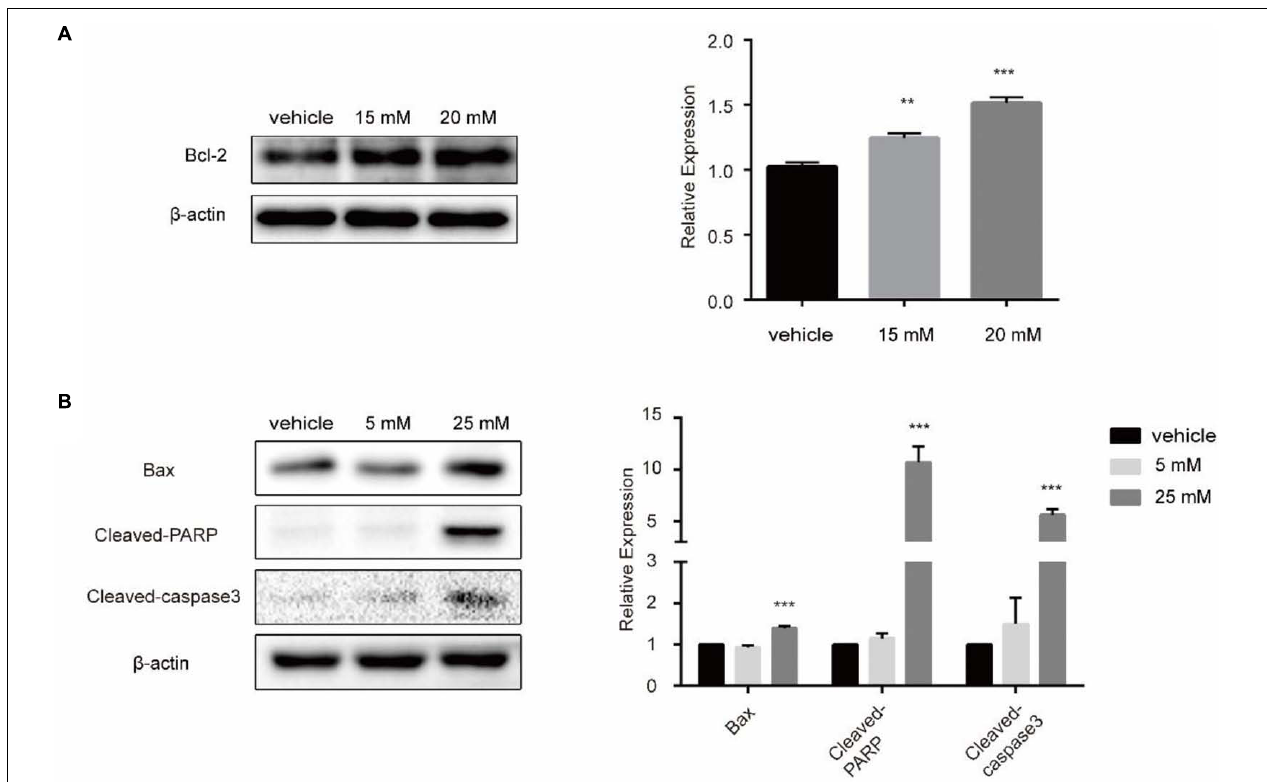
FIGURE 8 | The influence of lactic acid and propionic acid on the apoptosis of SW480 cells. (A) Lactic acid inhibited the apoptosis of SW480 colorectal cancer cells. (B) Propionic acid promoted the apoptosis of the SW480 colorectal cancer cells. ** P < 0.01, *** P < 0.001 vs.